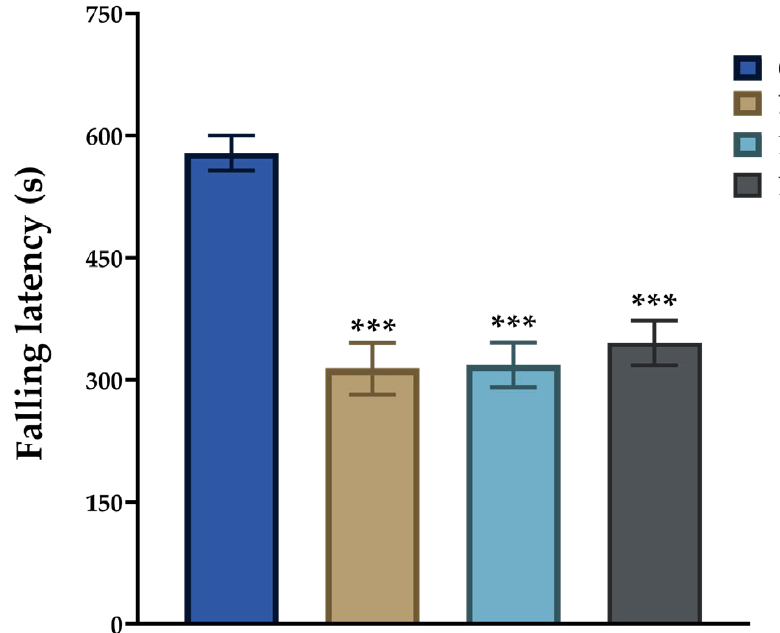
Figure 3. Falling latencies of normoglycemic rats administered with saline solution (control) and diabetic rats administered with saline (DM), 5 mg/kg vortioxetine (DM + Vort 5) or 10 mg/kg vortioxetine (DM + Vort 10) in the Rota-rod tests. Values are given as mean ± S.E.M. Significant difference against control group *** p < 0.001. One-way ANOVA, post hoc Tukey’s HSD multiple comparison test, n =